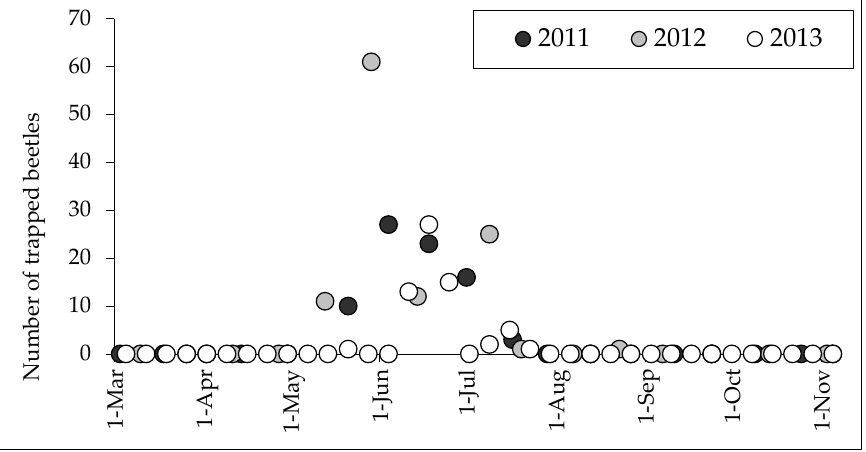
Figure 6. Seasonal flight activity of E. capucina based on trapped individuals in the period March–November during all study years.